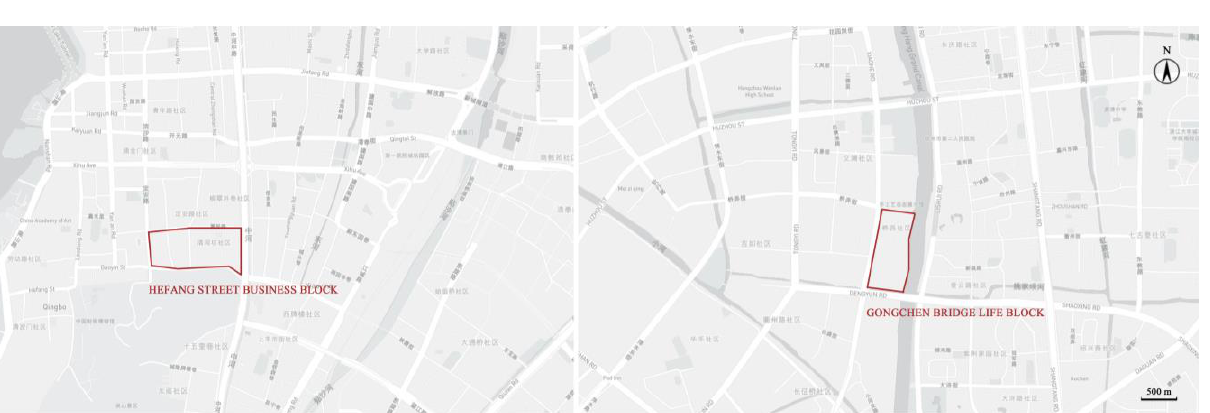
Figure 5. Morphological evolution of Gongchen Bridge Block. (Self-painted according to the histor- ical evolution of Gongchen Bridge).